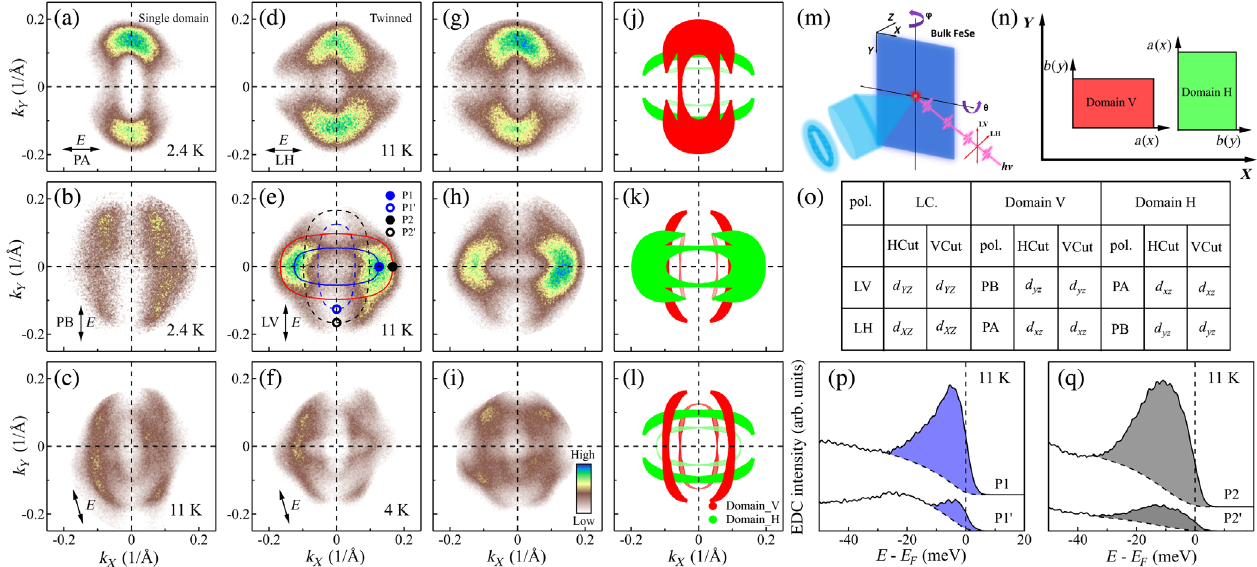
FIG. 2. Fermi surface mapping of twinned FeSe. (a) – (c) The Fermi surface mappings of the single-domain FeSe measured under the PA (a), the PB (b), and a mixed (c) polarization geometries. (d) – (f) The Fermi surface mappings of the twinned FeSe measured under the LH (d), the LV (e), and a mixed (f) polarization geometries. The measurement temperatures are marked at the bottom left corner in (a) – (f). (g) – (i) Simulated Fermi surface from the single-domain data in (a) – (c). Under the PA polarization geometry, (g) is obtained by summing up the signal of the vertical domain in (a) and that of the horizontal domain in (b) but rotated by 90°. Under the PB polarization geometry, (h) is obtained by rotating the data in (g) by 90°. Under the mixed polarization geometry, (i) is obtained by the summation of signals from the vertical domain in (c) and from the horizontal domain also in (c) but rotated 90°. (j) – (l) Schematic of the observed Fermi surface in twinned FeSe from the horizontal domain (green lines) and the vertical domain (red lines) corresponding to data in (d) – (f). (m) Schematic drawing of the experimental geometry with LV and LH polarizations. X , Y , and Z axes are defined as laboratory coordinates (LC). (n) Schematic drawing of two domains in nematic state in lab coordinates. The two domains are rotated 90° with each other. For domain V , the x ( y ) axis is parallel to X ( Y ) axis in LC while for domain H, it is reversed. (o) Summary of the allowed orbitals under LV and LH polarization geometries defined for lab coordinates and each domain along the high-symmetry cuts. (p) – (q) The photoemission spectra (EDCs) on the Fermi surface of two domains. The location of the 4-momenta is marked in (e). For each EDC, the peak area is obtained after subtracting the background. The obtained area ratio between the P1 and P 1 0 points is 7.3 in (p) and between the P2 and P 2 0 points is 5.3 in (q). The ratio is used to estimate the orbital components of d xz and d yz for the measured momentum